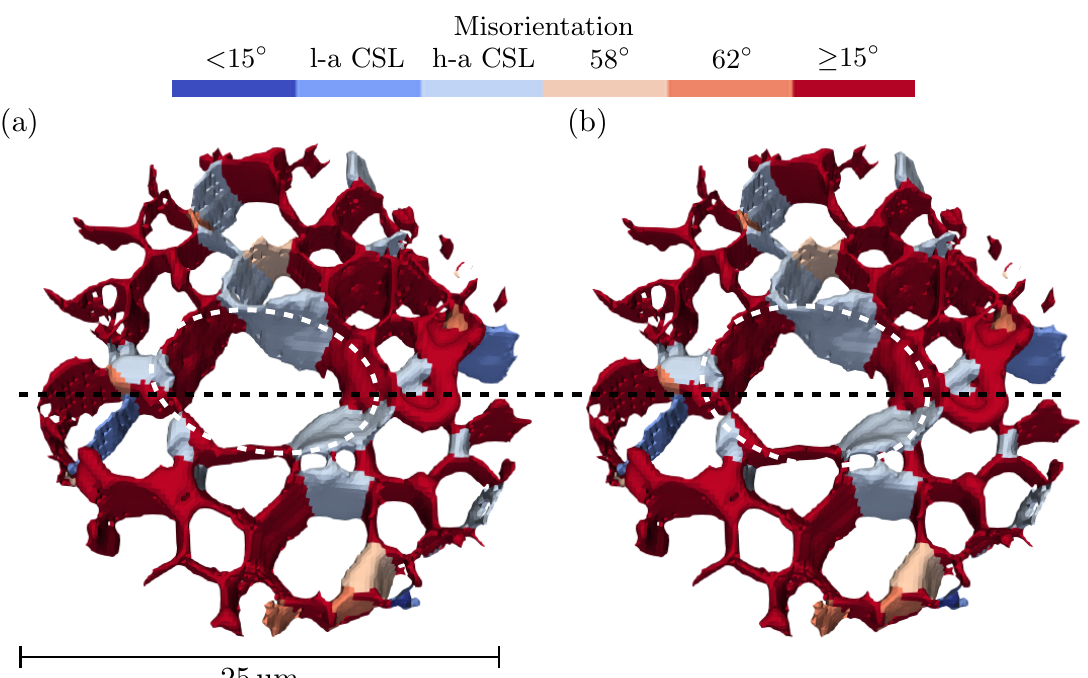
Figure 8. 3D renderings of the grain boundary network before and after heat treatment. The grain boundaries are coloured based on their misorientation angle. Blue and light blue represent low-angle CSL (l-a CSL) and high-angle CSL (h-a CSL) boundaries, respectively. The dashed ellipses indicate the location of the whisker. The dashed black line indicates where the volume in Figure 4 is sliced: ( a ) before heat treatment; and ( b ) after heat treatment.